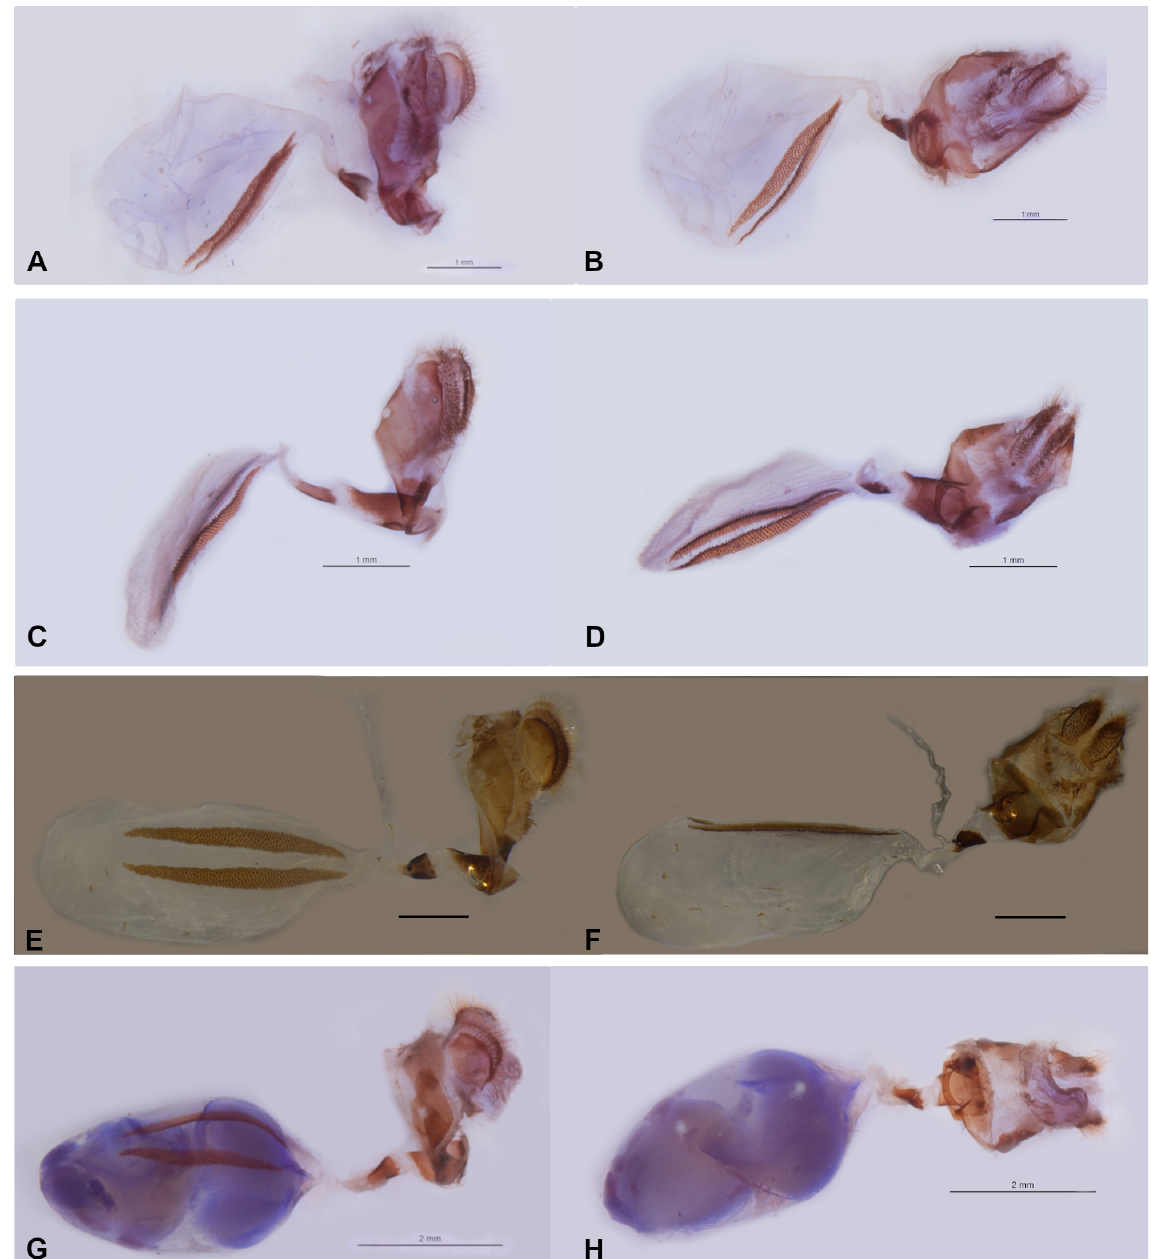
Fig. 6. Zischkaia “ pacarus clade”, female genitalia. A–B . Z. chullachaki Nakahara & Zacca, sp. nov., ♀, lateral and ventral views (Genitalic vial DZ 36. 508). C–D . Z. baku Zacca, Dolibaina & Dias, sp. nov., ♀, lateral and ventral views (Genitalic vial: DZ 5. 571). E–F . Z. arenisca Nakahara, Willmott & Hall, sp. nov., ♀, lateral and ventral views (Genitalic vial: SN-17-174). G–H . Z. pacarus (Godart, [1824]), ♀, lateral and ventral views (Genitalic vial: DZ 36.